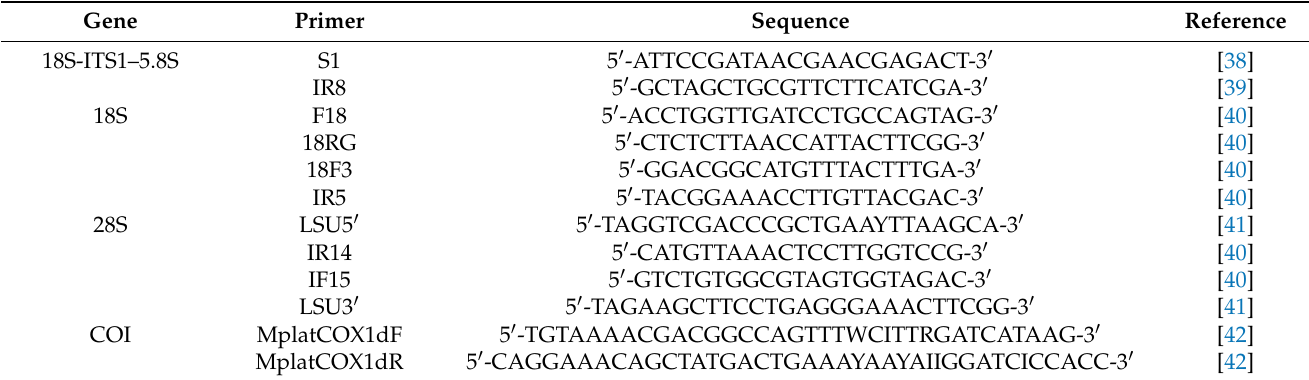
Table 1. Primers used for amplification and